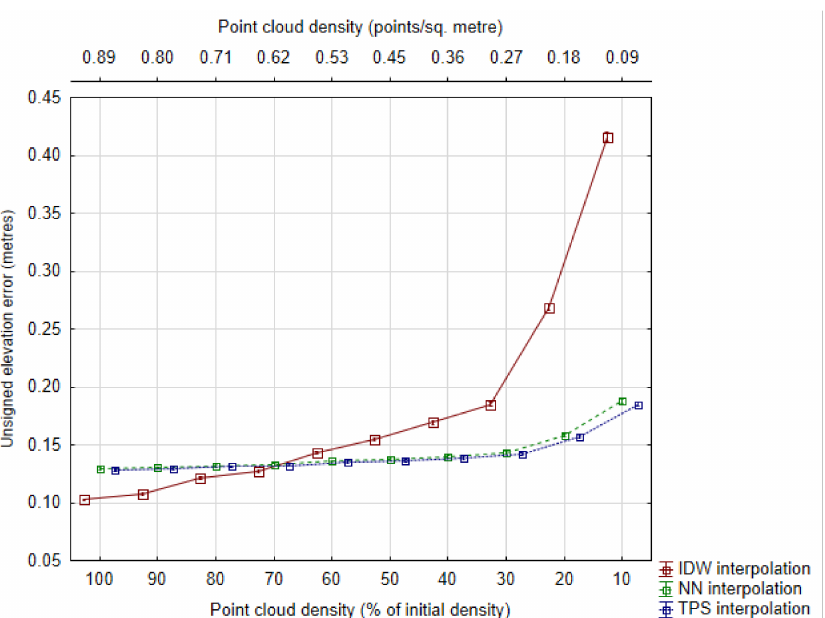
Figure 5. Mean unsigned elevation error as a measure of DTM accuracy, across different point densities. Whiskers represent the 95% confidence interval of mean values. Points are horizontally offset for